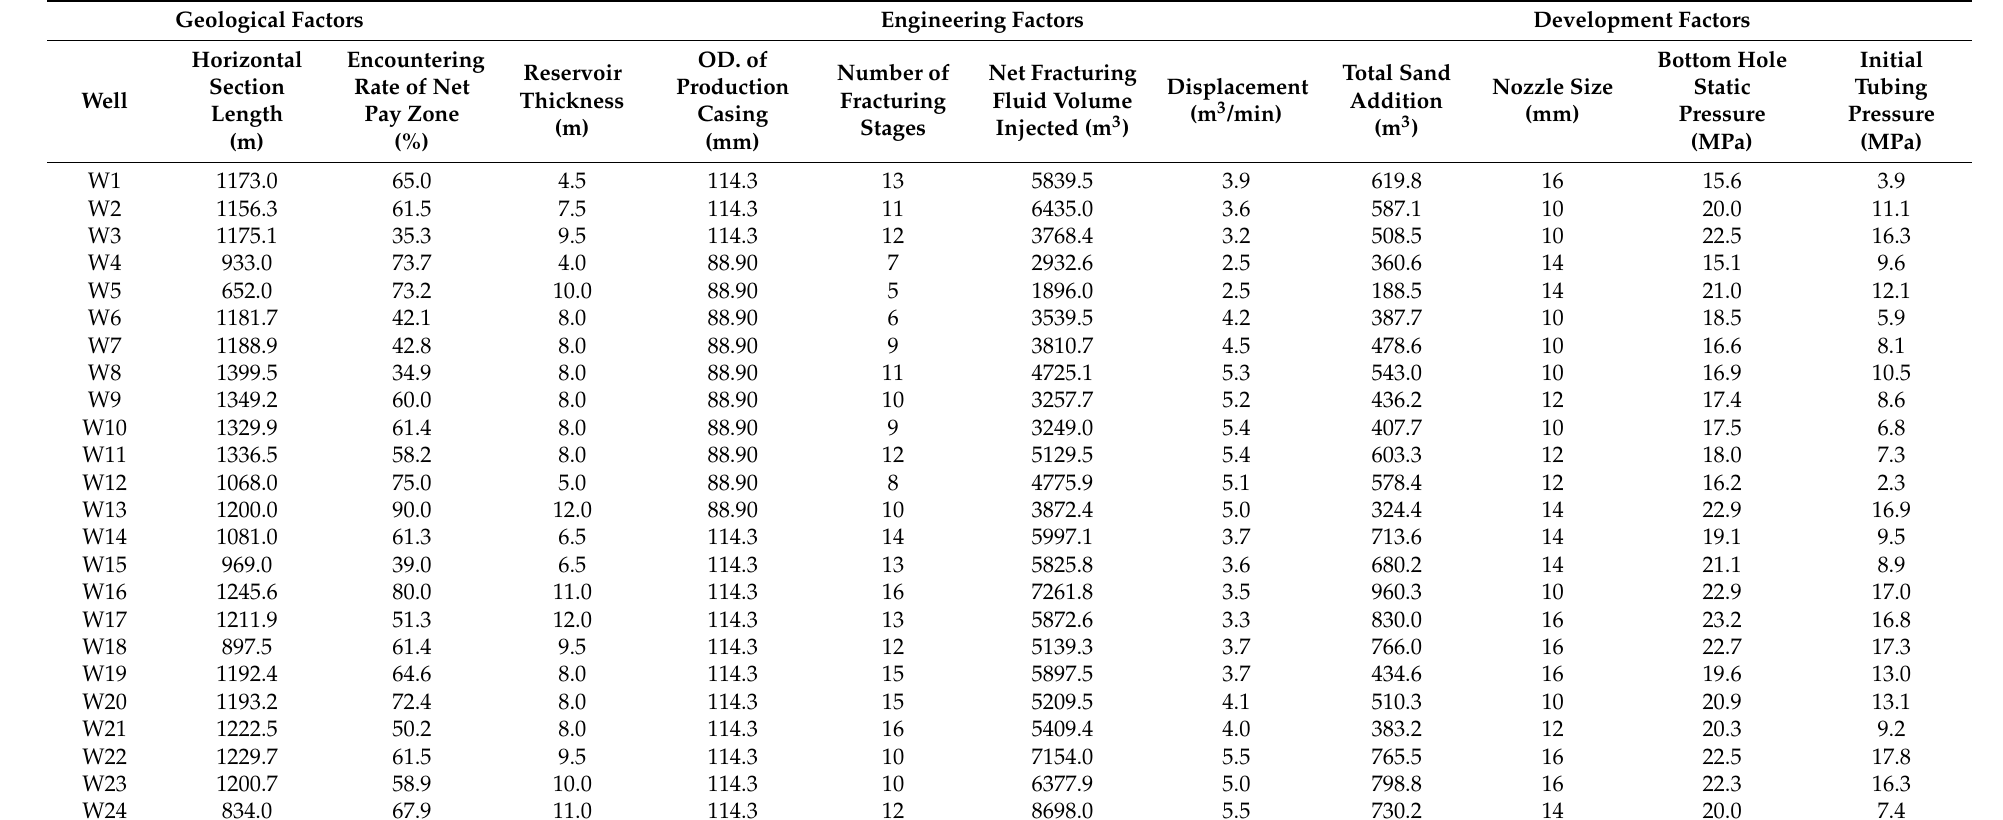
Table 5. Indicative parameters of CPII for horizontal